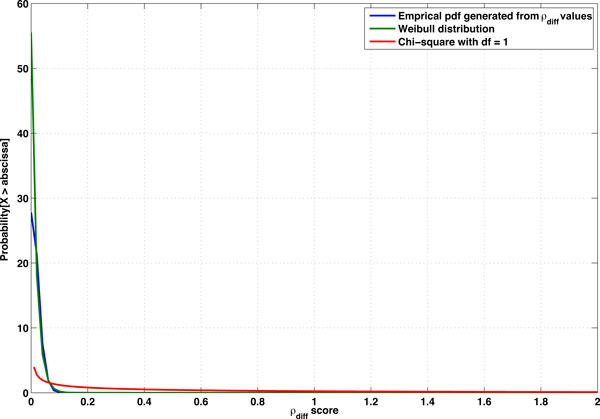
The frequency distribution of ρdiff values from WTCCC datasets. The plot shows the empirical probabilty density function (pdf) generated from combined ρdiffvalues from all seven diseases of WTCCC datasets.The pdf plots generated from each disease are indistinguishable from combined pdf. The plots for Weibull distribution (k = 1, λ=0.018) and Chi-square distribution (degree of freedom = 1) are shown in the same axes.